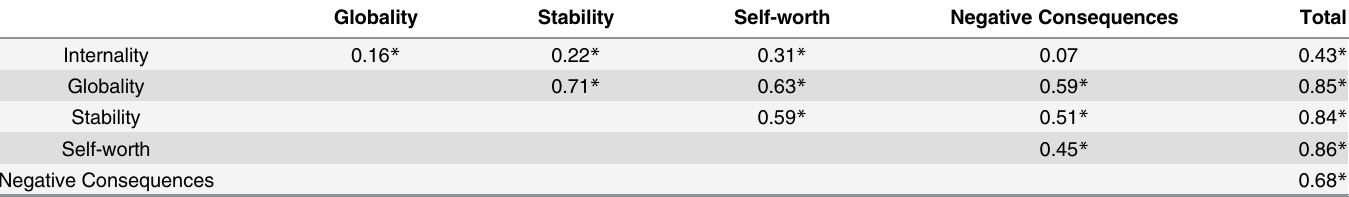
Table 2. Subscale